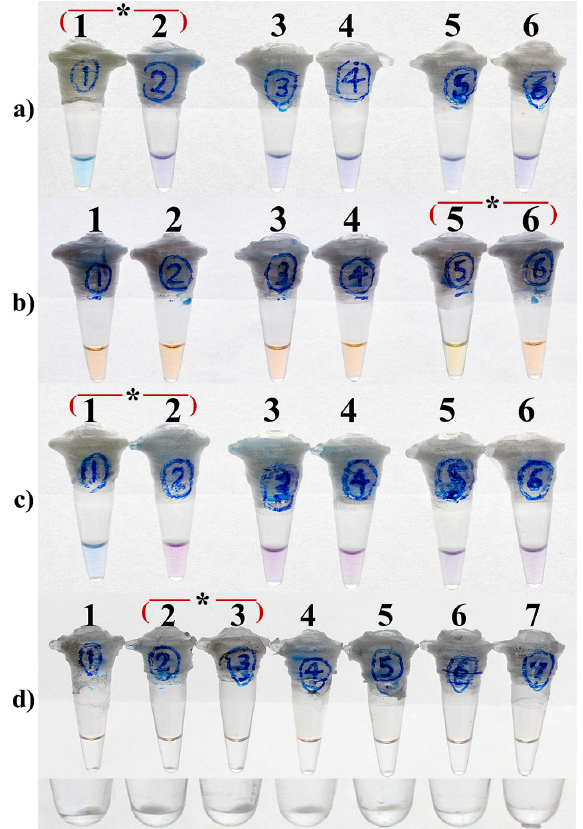
Figure 3. Optimization of the dNTP concentration in HNB-LAMP ( a ), Calcein-LAMP ( b ), EBT-LAMP ( c ), and turbidity-LAMP ( d ) for the detection of M. tuberculosis . ( a – c ) 0.5 mM (tubes 1 and 2), 1 mM (tubes 3 and 4), and 1.4 mM (tubes 5 and 6) dNTPs. Tubes with even and odd numbers, respectively, represent negative and positive reactions. In ( d ), tubes 1 to 6 are positive reactions, respectively, containing 0.5, 1, 1.4, 2, 2.5, and 3 mM dNTPs, and tube 7 is the negative control. The image on the bottom shows the close-up view of ( d ) focused on the pellets of pyrophosphate magnesium. The asterisks indicate the optimal concentration of Mg 2+ . Table 1. Determination of the optimal concentration of EBT in the LAMP assay by applying different duration times to the reactions.